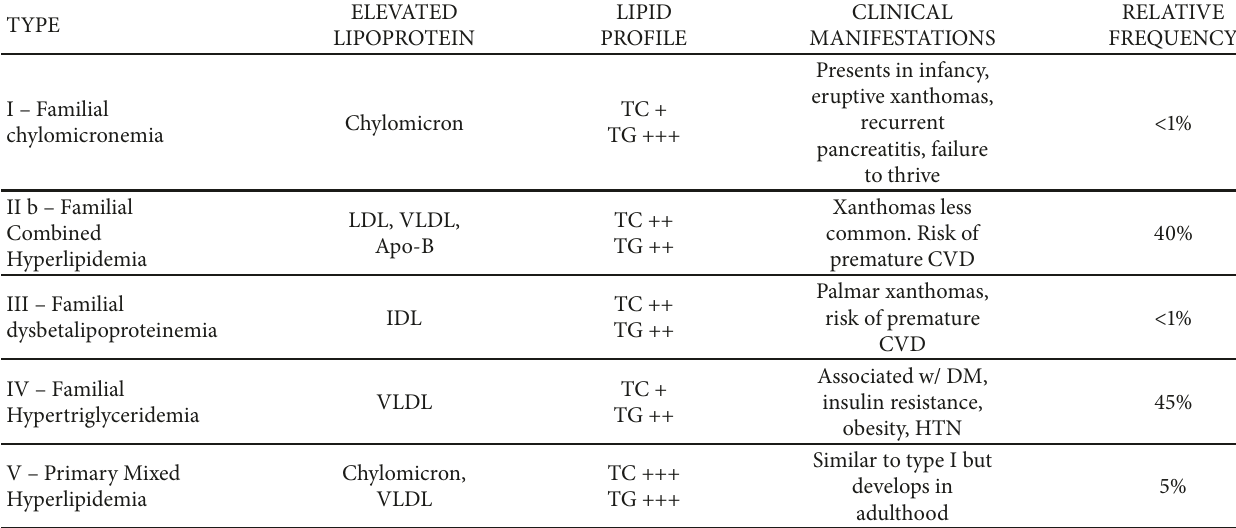
Table 2: Fredrickson classification of primary hypertriglyceridemia [6,